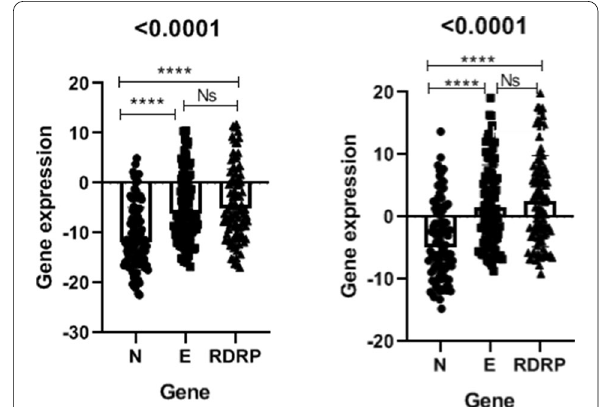
Fig. 4 Comparison of the cycle threshold (∆Ct) value of SARS‑COV‑2 expression. A HPRT gene was used as an internal control. A significant difference is indicated by *P < 0.05. ****, Ns Not significant (0.611). = B RP gene was used as an internal control. A significant difference is indicated by *P < 0.05. ****, Ns Not significant, =